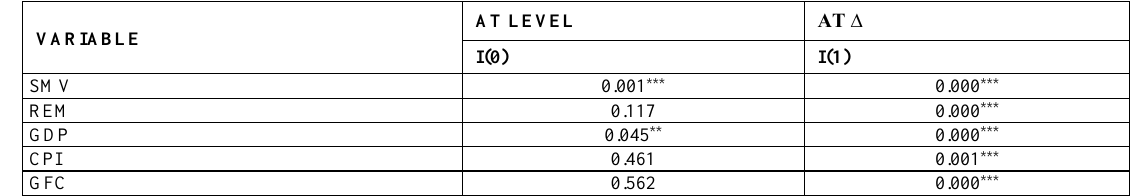
Table 2. Unit root test